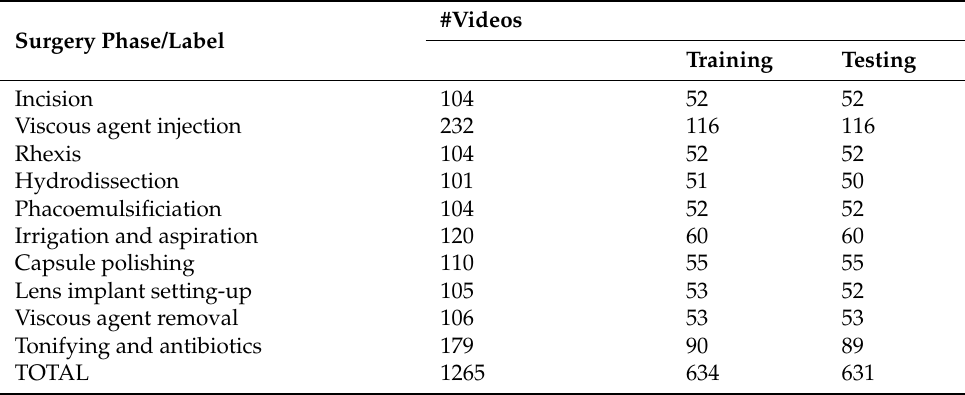
Figure 6. Overview of 10 different surgical phases in cataract surgery. Table 1. Dataset (Cataract-101) preparation.